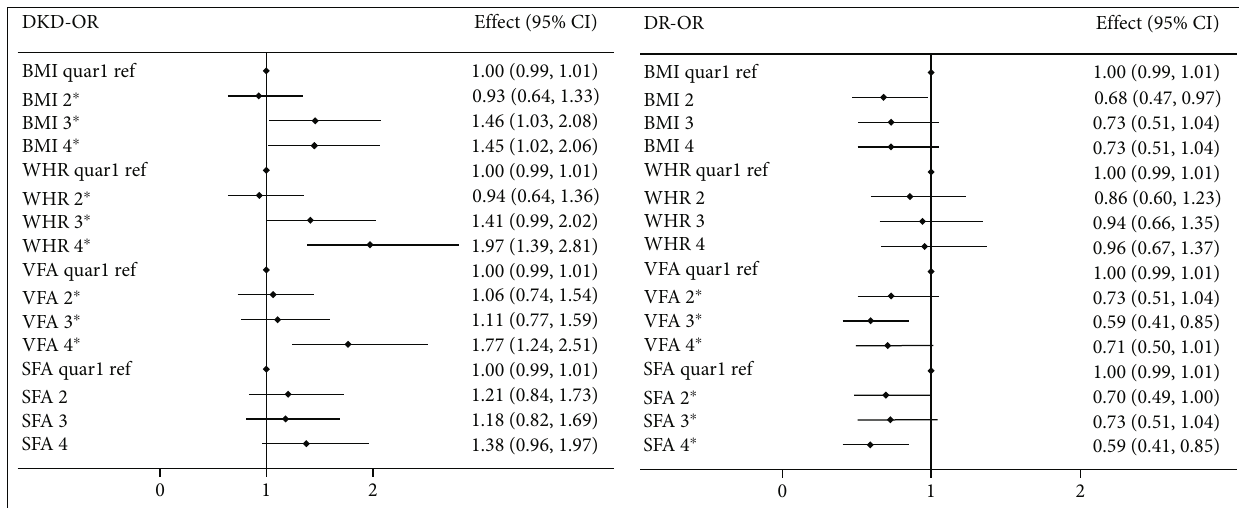
Figure 1: The associations between obesity indices and DKD/DR by quartiles. ∗ P for trend < 0.05. Abbreviations: DKD indicates diabetic kidney disease; DR: diabetic retinopathy; BMI: body mass index; WHR: waist to hip circumference ratio; VFA: visceral fat area; SFA: subcutaneous fat area; Quar: quartile; Ref: reference; CI: con fi dence